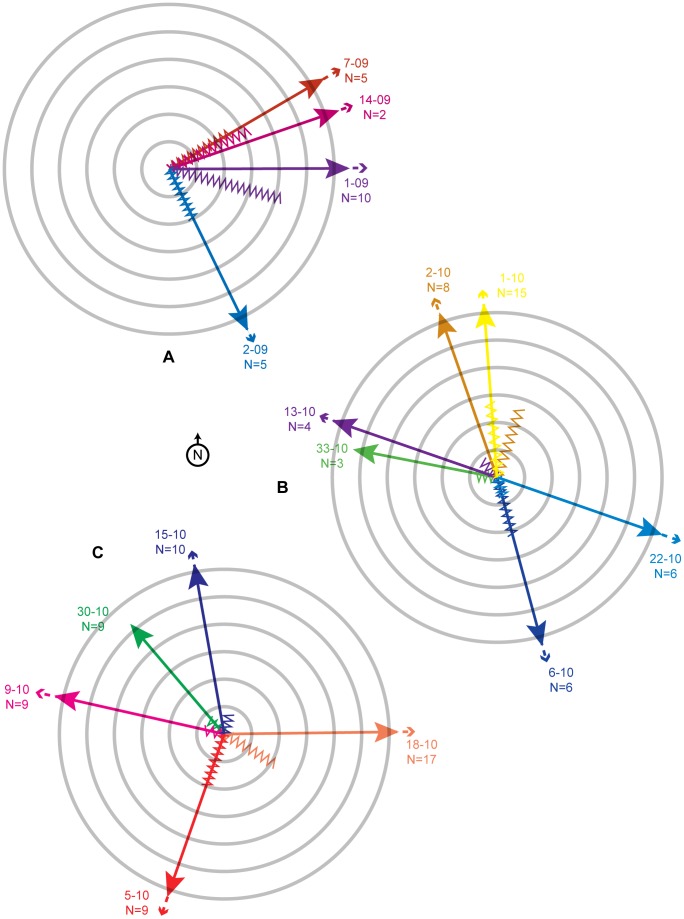
Compass plots depicting flight directions indicated by dancers and following flights.(A) observations from 2009, (B, C) observations from 2010. Dances of each worker were numerous; directions and distances indicated were unanimous for all dancers in each bivouac. Each color represents dances and flight of a single bivouac. Each concentric ring represents either 3 s of dancing (zigzag lines)–waggle runs only for dances of >3 s duration, complete circuits for dances of <3 s–or 30 m of flight (straight lines). Most flights exceeded 150 m and disappeared from view, as indicated by broken lines. At periphery are identification numbers of bivouacs. N  =  maximum number of workers simultaneously dancing within 30 min before flight.